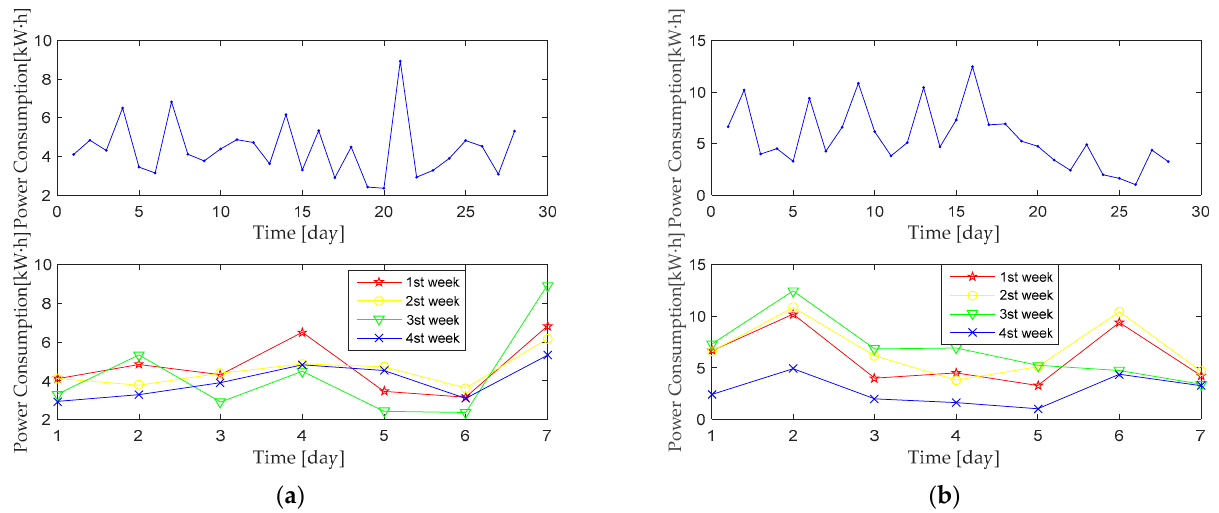
Figure 2. ( a ) Analysis of electricity curve of electricity meter in normal operation state. ( b ) Analysis of electricity curve of electricity meter in abnormal operation state.